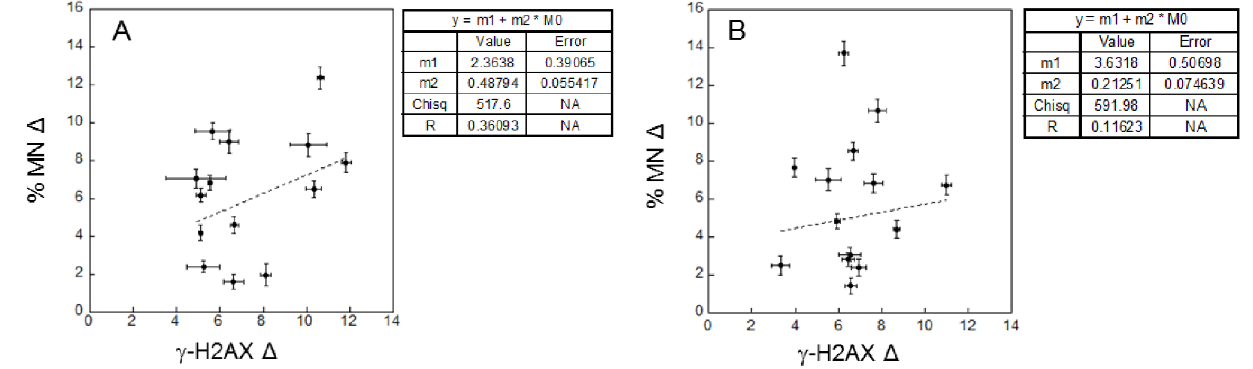
Figure 6. Lymphocytes radio-sensitivity (Delta, Δ) for MN frequency versus γ-H2AX in patients before ( A ) and after ( B ) I-131 treatment. The dotted lines represent linear weighed least-squares fits of the data. Error bars represent the propagation of the errors.